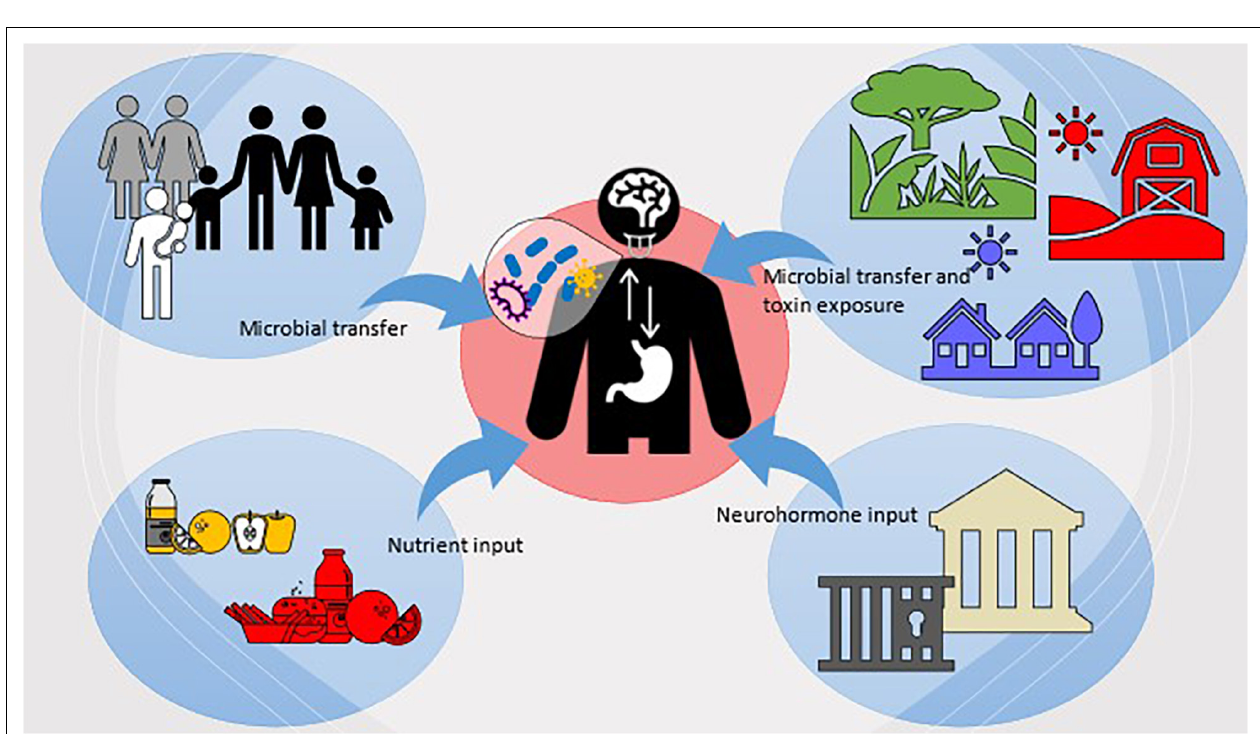
FIGURE 1 | Overview of mechanisms by which oral microbiota influence and contribute to NPD outcomes. 1 Xue et al. (25); 2 Xia et al. (43); 3 Dinarello et al. (94); 4 Ding et al. (45); 5 Bulgart et al. (39); 6 Watanabe et al. (40); 7 Dominy et al. (42); 8 Lin et al. (26); 9 Olsen and Hicks (50); 10 Jentsch et al. (56); 11 Duran-Pinedo et al. (30); 12 Cunha et al. (28); 13 Vieira et al. (33).